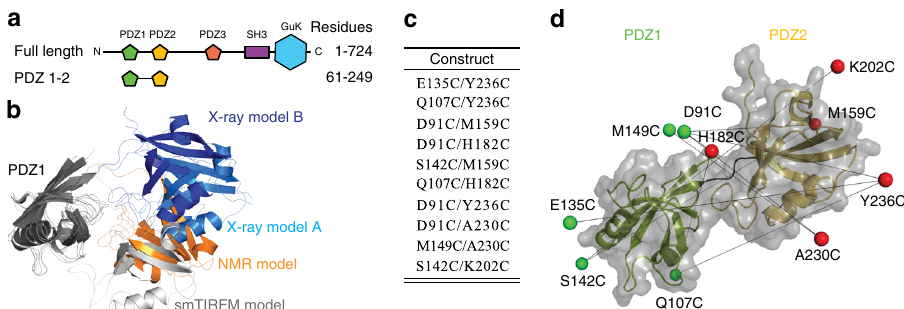
Fig. 1 The PDZ1-2 tandem from PSD-95. a PSD-95 contains fi ve protein-interaction domains connected by linkers of varying length. The N-terminal PDZ tandem contains the fi rst two PDZ domains (residues 61-249). b Structural models of the PDZ tandem determined with different experimental methods. PDZ1 (gray) from each model was aligned to highlight conformational differences. PDZ2 is colored according the method used to resolve the structure. Models from the crystal structure (blue and cyan) [PDB ID: 3GSL]. Model from NMR based on residual dipolar coupling, which was kindly provided by M. Zhang (orange). Model from smFRET (white). c Cysteine mutations used for fl uorescent labeling in the PDZ tandem of PSD-95 (Residues 60-249). The fi rst residue is in PDZ1 while the second is in PDZ2. Each pair forms a single distance restraint that is measured independently. d Network of FRET restraints in the PDZ Tandem. Mean position of each dye (spheres) at the associated cysteine residue as determined by modeling. PDZ1 sites colored green. PDZ2 sites colored red. Black lines are shown between mean positions